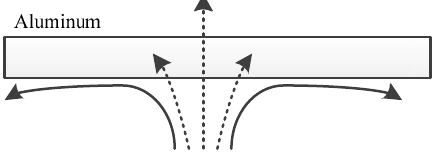
Figure 4. Magnetic field lines of shield of aluminum.